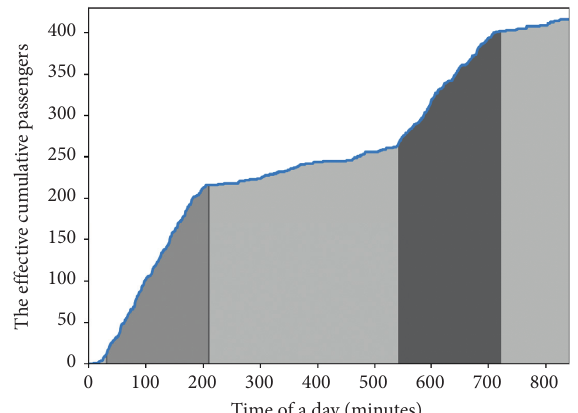
Figure 12: The effective cumulative passenger demand of Bus Line 622.